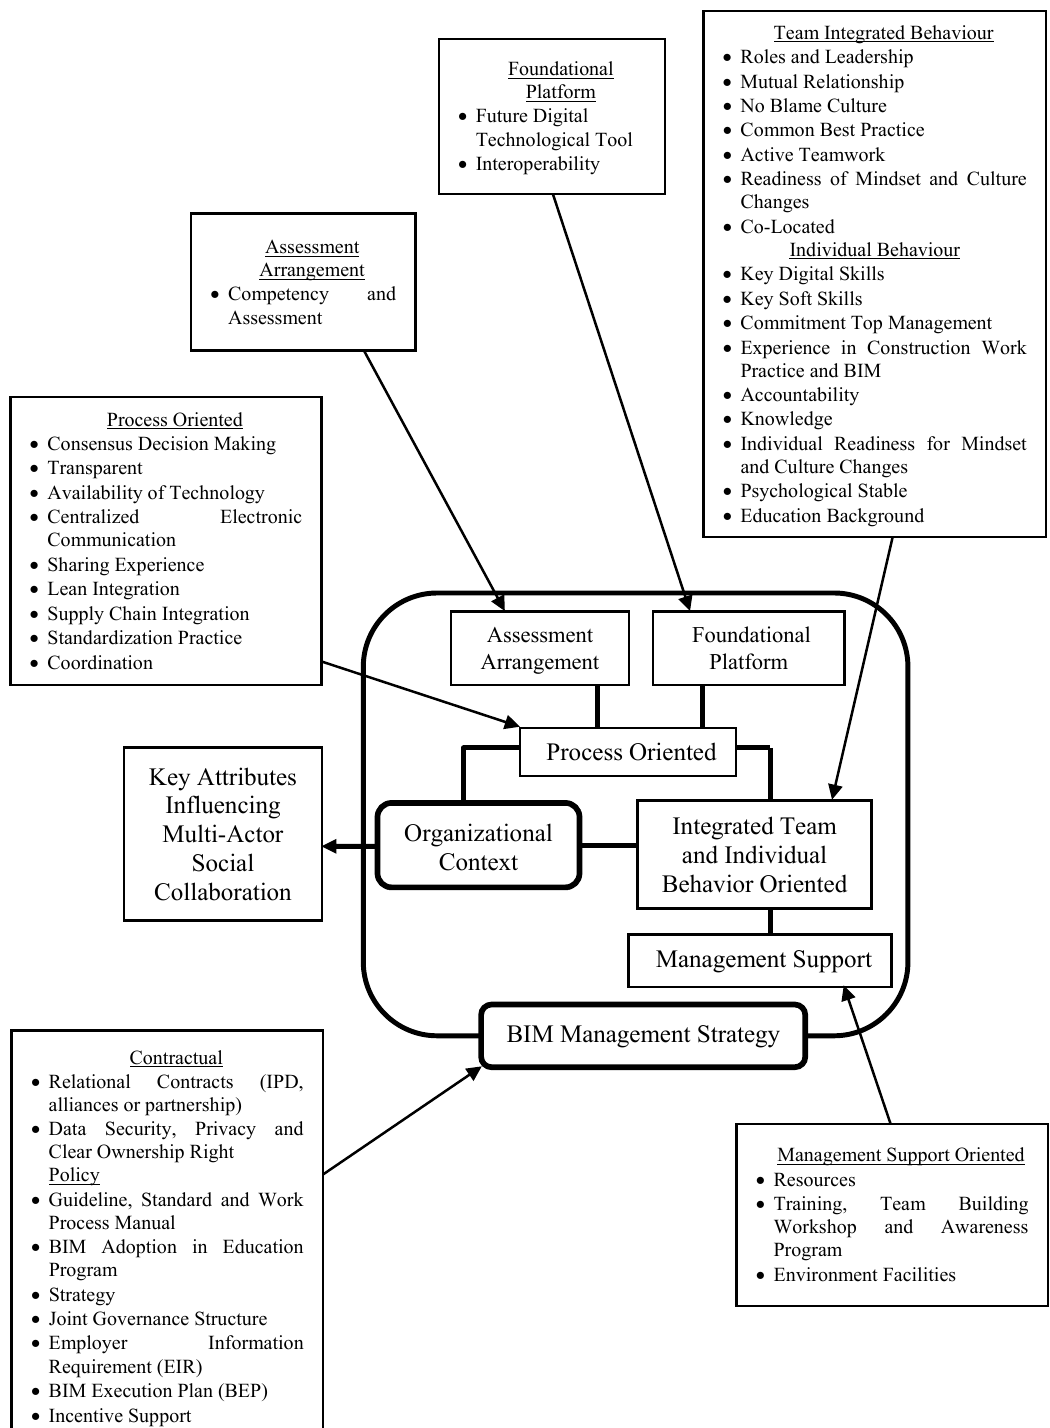
Summary of 40 Attributes Identified from Existing Literature (Adapted from Noor, Che Ibrahim and Belayutham,